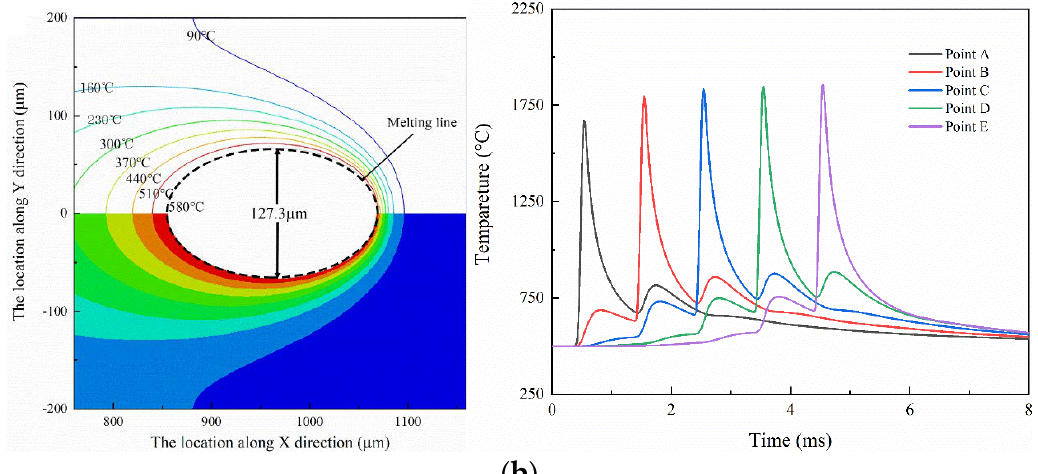
Figure 1. Temperatures predicted by Gaussian heat source model [43]: ( a ) finite element model and scanning strategy; and ( b ) temperature variations. (Reprinted/adapted with permission from Ref. [43], 2021, Springer nature).